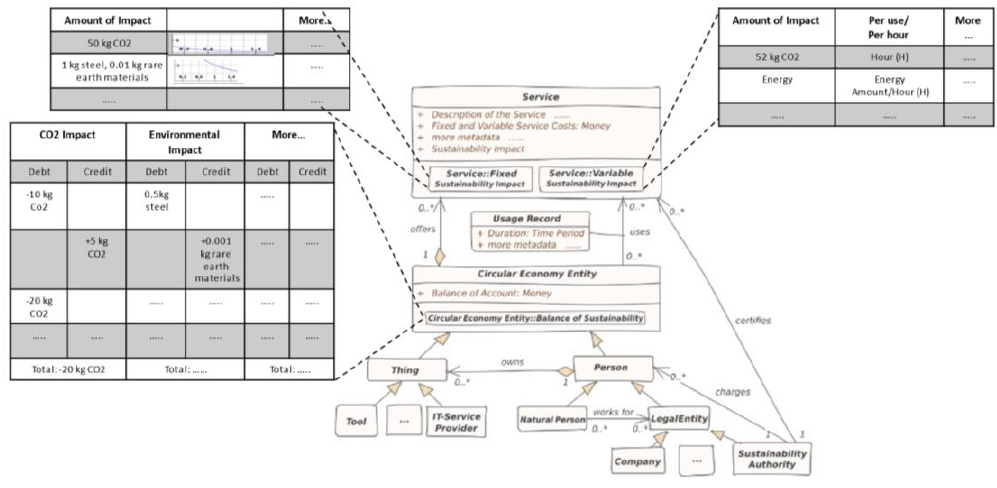
Figure 2. Circular Economy meta-model.